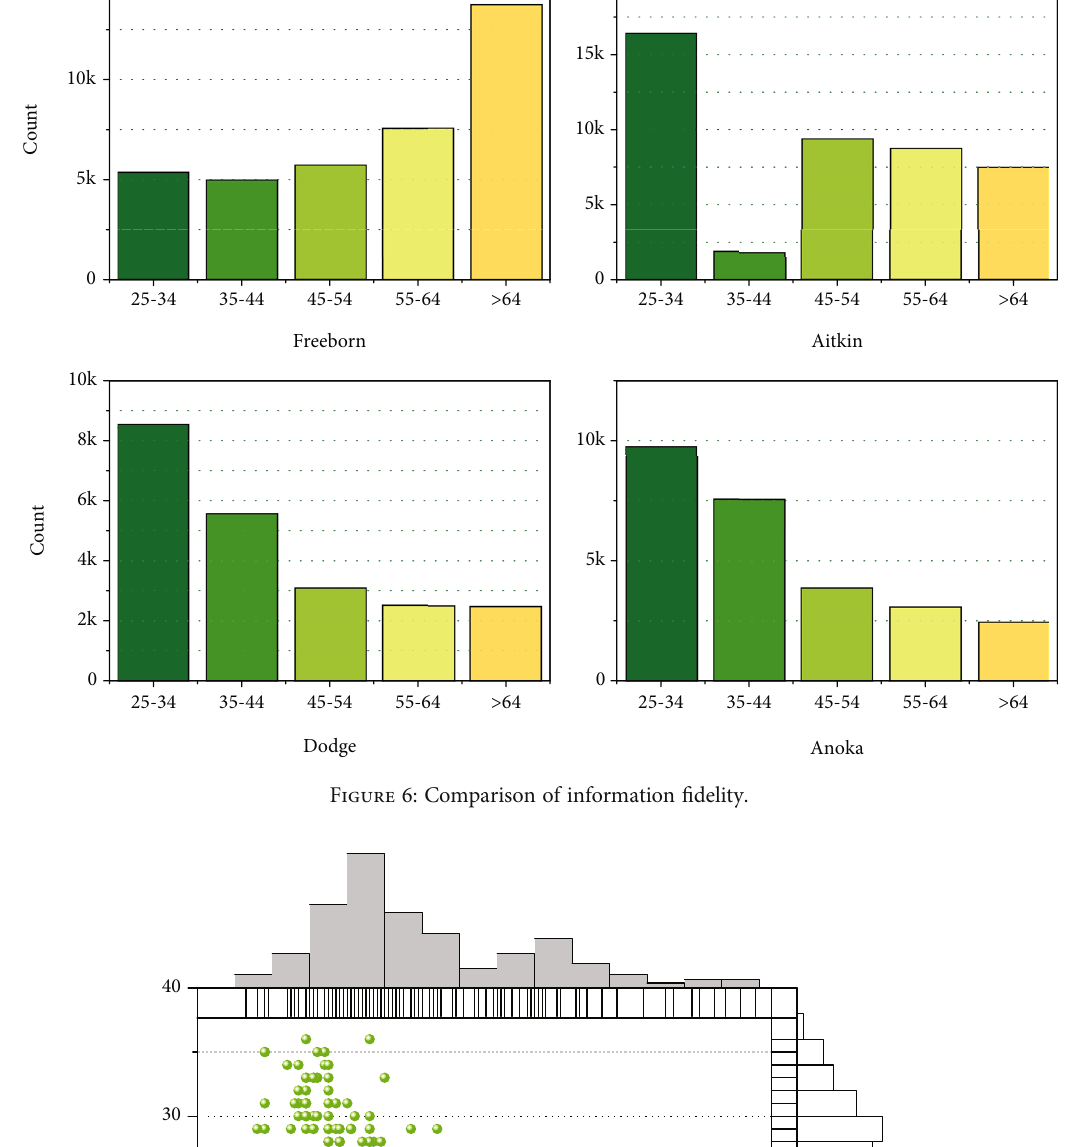
Figure 7: Correctness veri fi